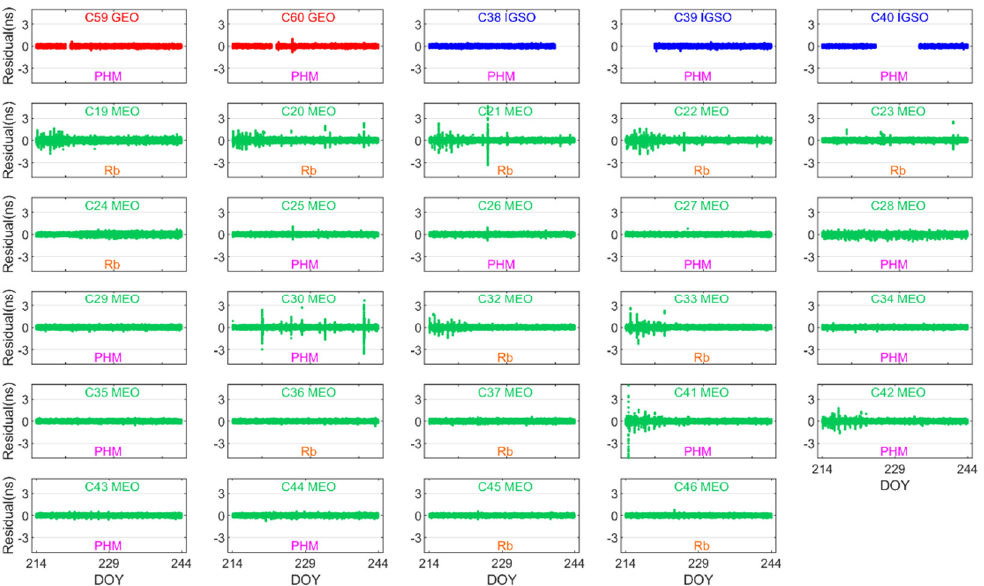
Figure 12. Fitting residual series of the BDS-3 satellites.